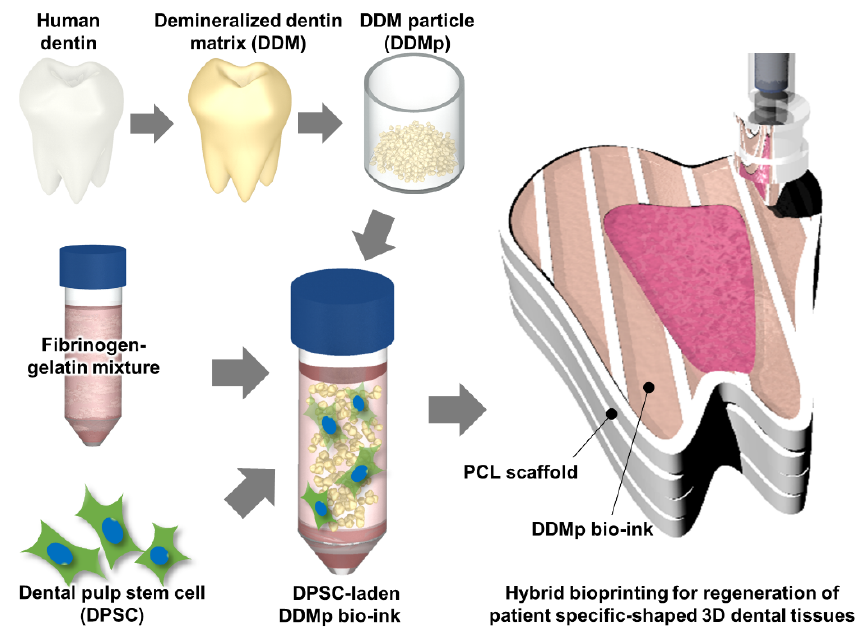
Figure 1. Schematic illustration of the preparation of a demineralized dentin matrix particle (DDMp) bio-ink for 3D bioprinting.